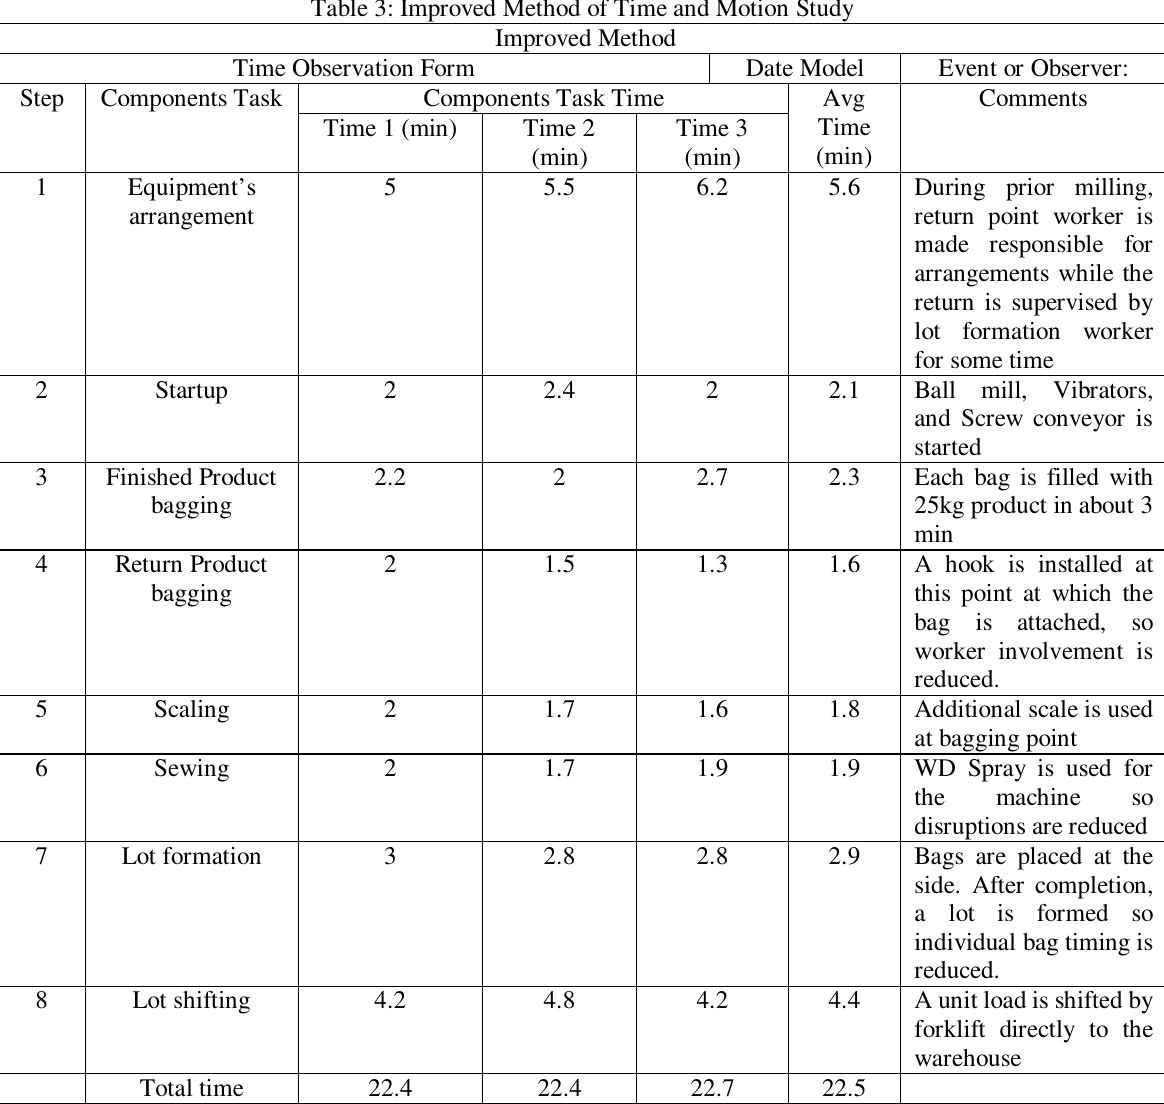
Table 3: Improved Method of Time and Motion